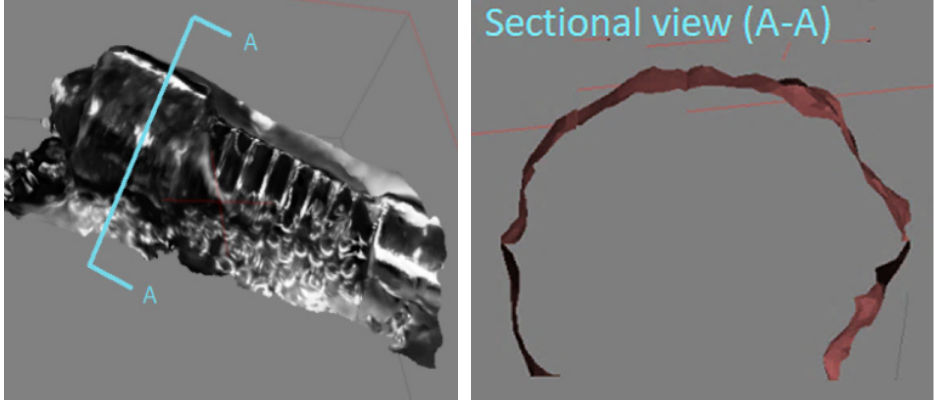
Figure 9. Images identified for relative light.